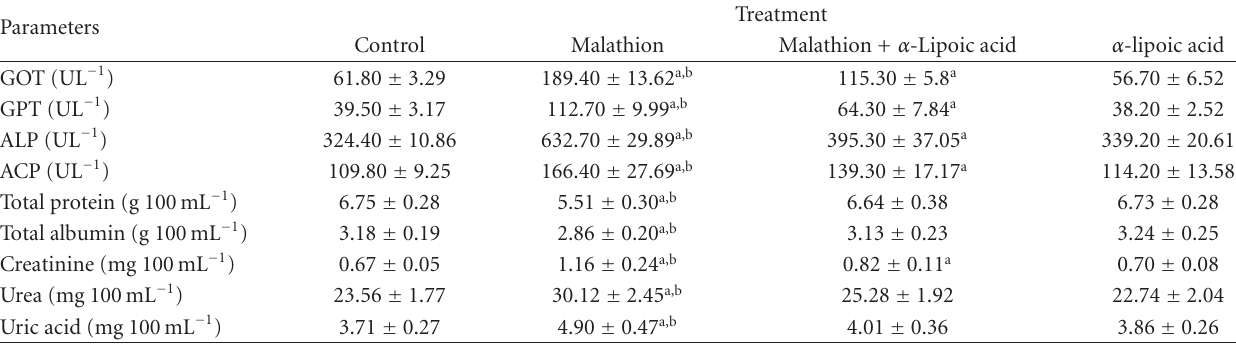
Table 1: Changes in values of serum GOT, GPT, ALP, ACP, total protein, total albumin, creatinine, urea, and uric acid in rats treated